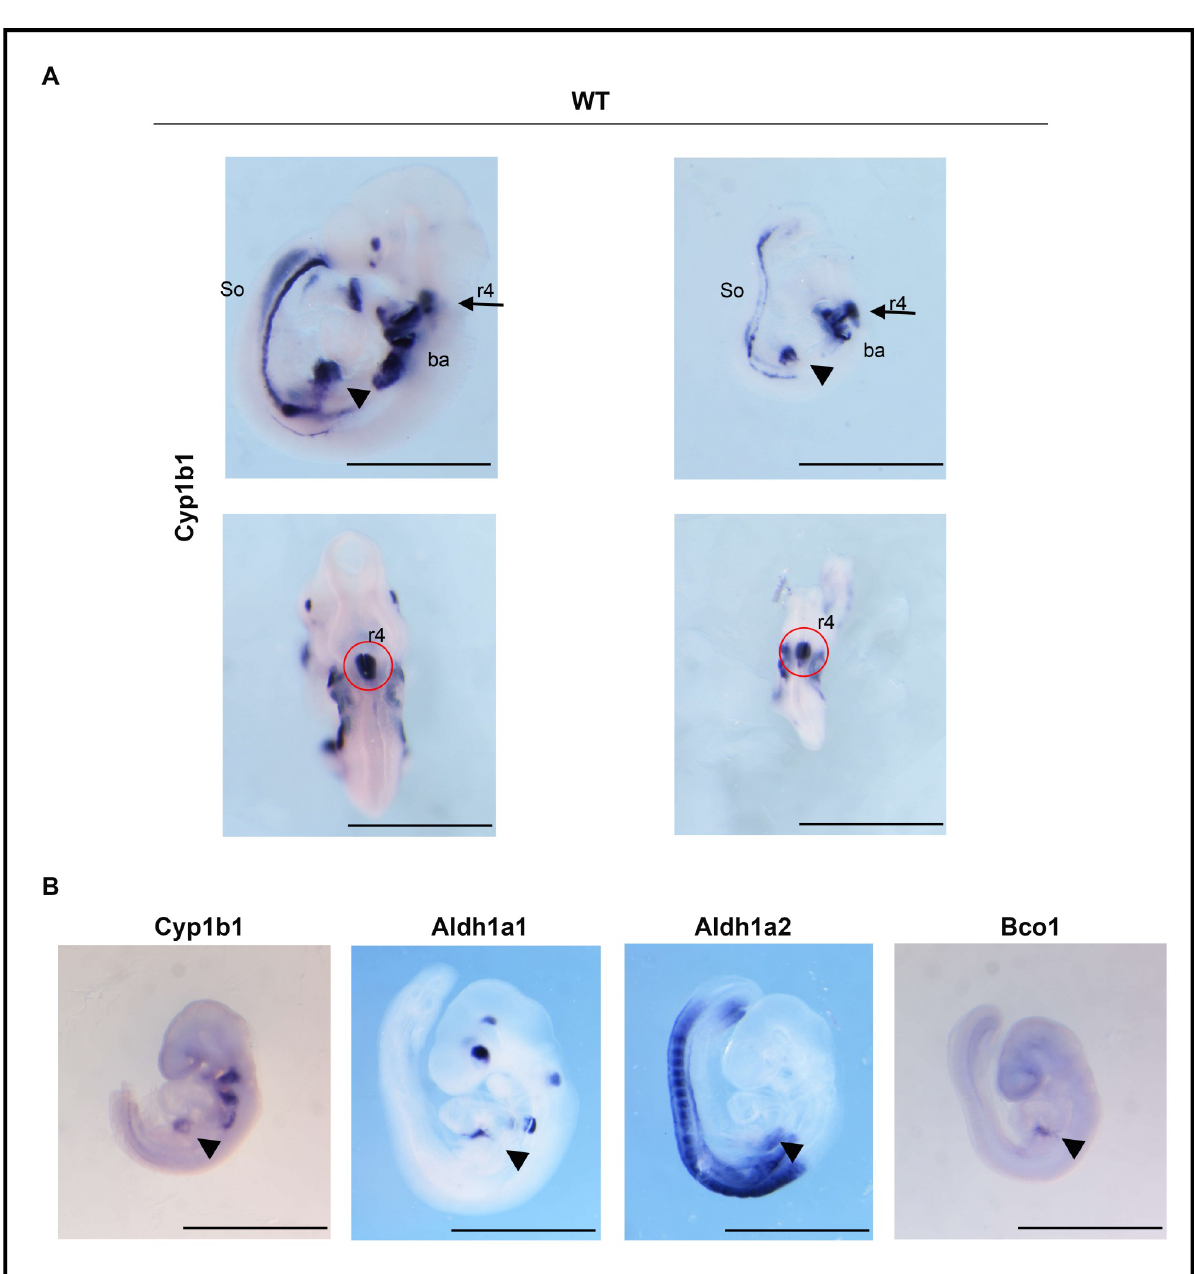
Fig 4. Cyp1b1 expression in the embryo at E9.5; overlap with Bco1 in the STM. E9.5 WT embryos of different sizes from dams administered a vitamin A-sufficient (Suff) diet were probed for Cyp1b1 . Lateral (upper) and dorsal (lower) views are shown for two stained embryos. Noted are hindbrain rhombomere 4 (r4, ventral side), branchial arches 2, 3, and 4 (ba), septum transverse mesenchyme (STM) (arrow head), and tail somites (So) (A). Cyp1b1 is adjacent to Aldh1a2 and Aldh1a1 in the foregut (arrow head) and r4 (red circle) and overlaps Bco1 in the STM (arrow head)